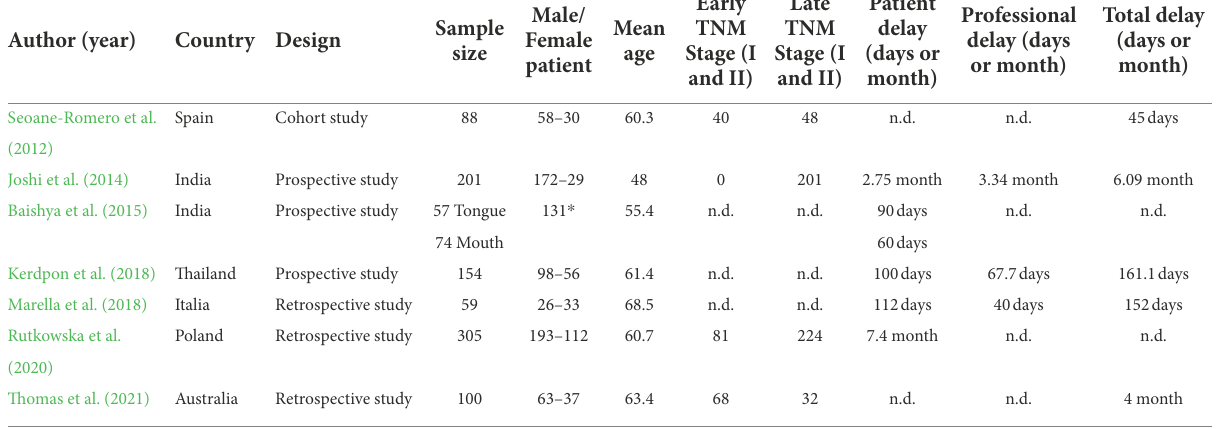
TABLE 1 Summary of studies from 2011 to 2021 regarding the diagnostic delay in